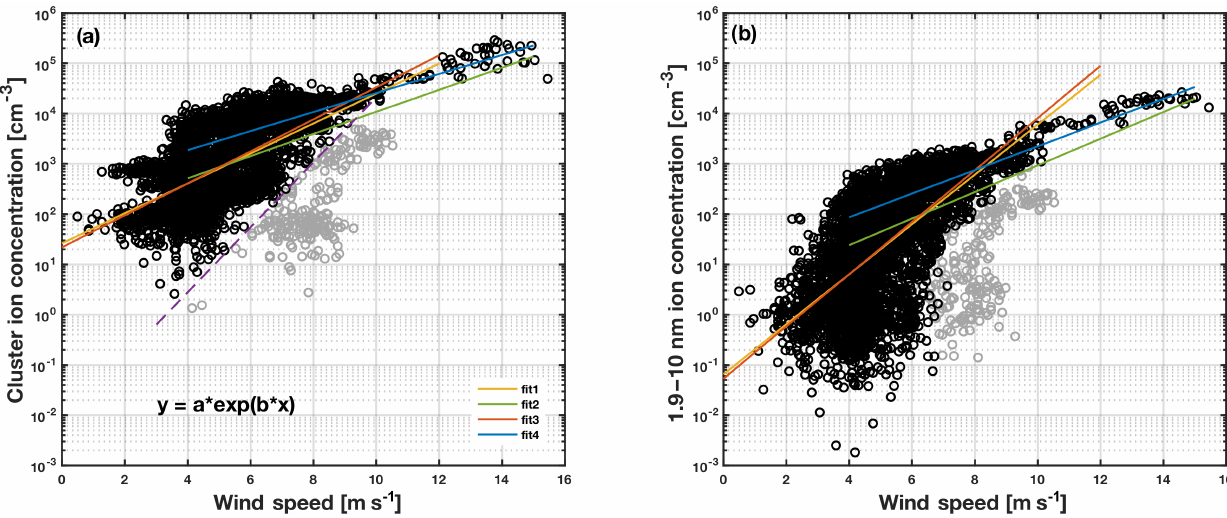
Figure 9. Ion concentrations as a function of wind speed: (a) ion concentration in the cluster size range (0.9–1.9nm) and (b) ion concentration in the size range of 1.9–10nm. The solid lines are linear fits to the data. Fits 1 and 3 are to data with a wind speed below the threshold wind speed (7ms − 1 ) and fits 2 and 4 are to data above the threshold wind speed. Fits 1 and 2 are obtained based on all data below or above the wind speed threshold, respectively. The data points in grey colour, however, are not taken into account in determining the fitting coefficients for fits 3 and 4. These grey data points correspond to cluster ion concentration values below the purple dashed line ( y = 0 . 0074 · e 1 . 4855 x ). The coefficients of these fits as well as the 95% confidence bounds of the coefficients and coefficient of determination measuring the goodness of fit are given in Table S1 in the